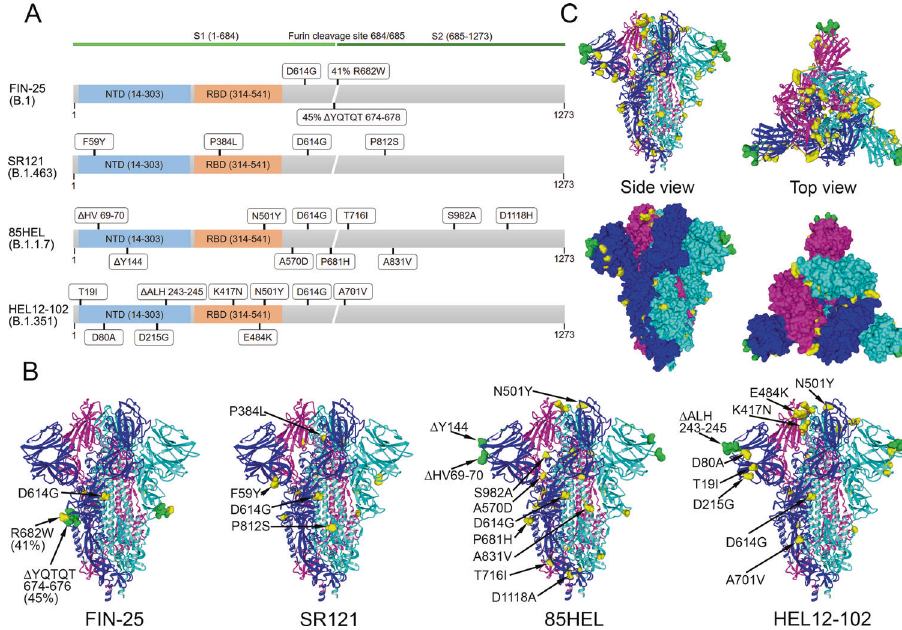
Fig. 2 Genetic analysis of virus variants and spike protein structure prediction. A Schematic presentation of S gene and amino acid changes in FIN-25 (B.1 lineage), SR121 (B.1.463), 85HEL (B.1.1.7), and HEL12-102 (B.1.351) virus isolates used in the present study. B Trimeric SARS-CoV-2 S protein, referred to as the spike, structure in the closed conformation (pdb: 6VXX). Amino acid substitutions (yellow) and deletions (green) as compared to the original spike structure. C Collective presentation of all amino acid changes found in virus isolates. Space- fi lling model indicating amino acids changes (yellow) and deletions (green) on the surface of a trimeric S protein. Side and top views are